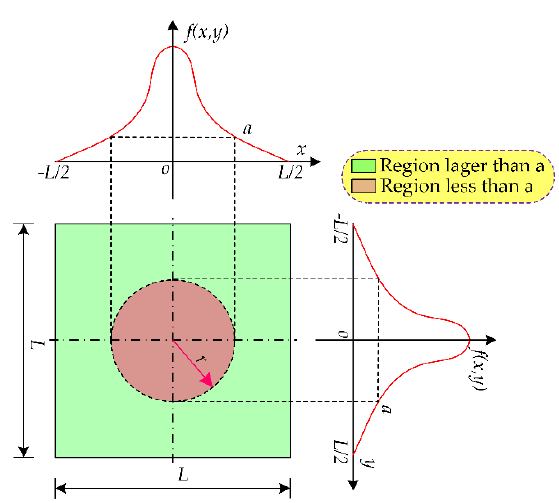
Figure 21. Schematic diagram of floor comfort assurance rate.